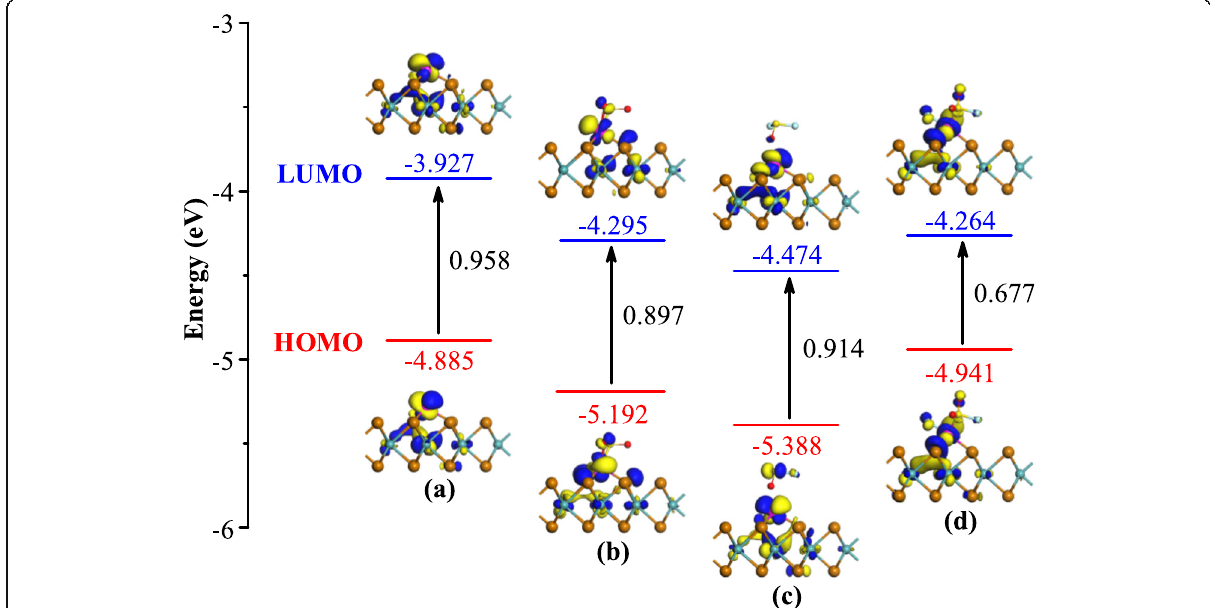
Fig. 7 Distributions and energies of FMO in a Rh-MoTe 2 system, b SO 2 system, c SOF 2 system, and d SO 2 F 2 system